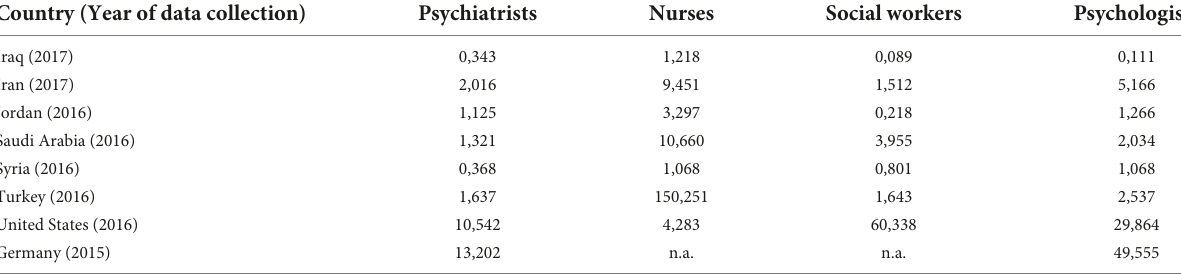
Country (Year of data